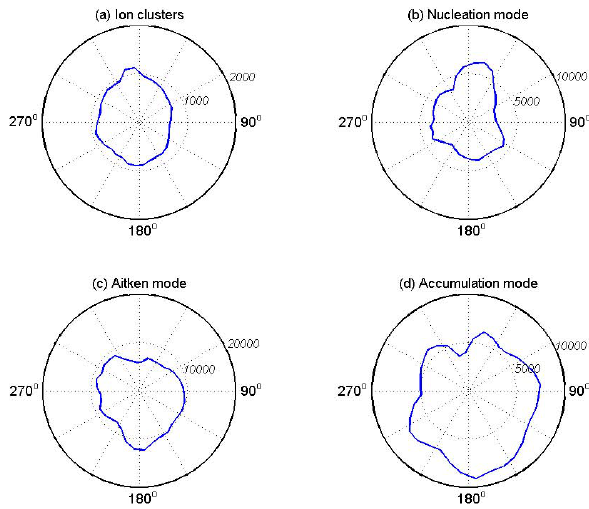
Fig. 3. Air ion and aerosol mode concentrations (all cm − 3 ) as a function of wind direction. (a) Ion clusters <2nm. (b) Nucleation mode 6–25nm. (c) Aitken mode 25–90nm. (d) Accumulation mode